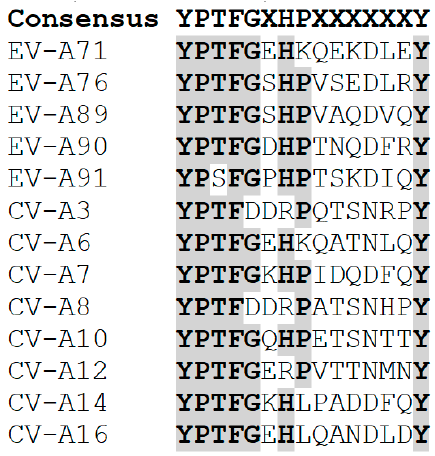
8 of 18 Figure 1. Position of VP1 BC loop and VP2 EF loop on the EV-A71 viral capsid. Representation of the EV-A71 VLP viral capsid. VP1, VP2 and VP3 structural proteins are shown in grey. The VP1 BC loop and VP2 EF loop are shown in black and labelled. PDB code: 4RQP. 4.4. Tetravalent Peptide-Based HFMD Vaccine Previous attempts were made to use the traditional VLP-based platform to produce a tetravalent HFMD vaccine. For instance, Zhang et al. (2018) produced each single VLP of EV-A71, CV-A16, CV- A6, and CV-A10 using a baculovirus-insect cell expression system, and then combined them to formulate a tetravalent HFMD vaccine [61]. They found the tetravalent vaccine elicited antigen specific and long lasting antibody responses in addition to passive protection conferred by the tetravalent vaccine-immunized sera against single or mixed infections with EV-A71, CV-A16, CV-A6, and CV-A10 in mice. However, large scale productions of the four VLPs will be costly and time-